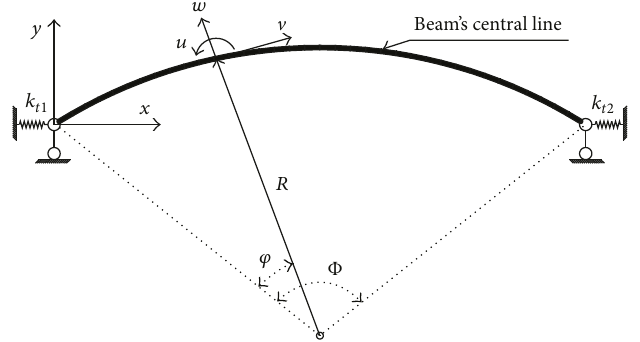
Figure 4: The model of the simply supported beam under the effect of temperature.